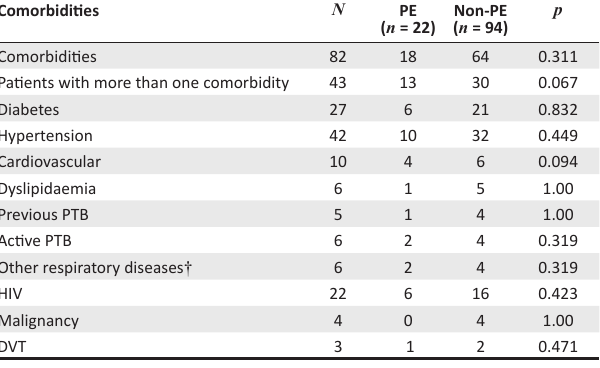
TABLE 2: Comorbidities.